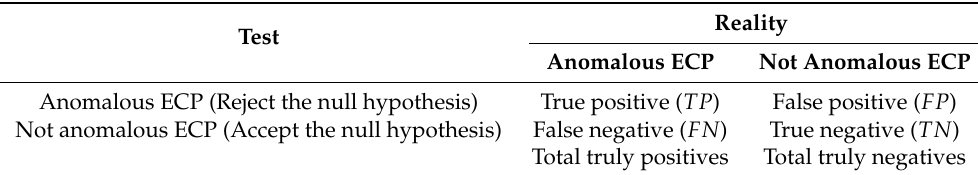
Table 1. Hypothesis testing for outlier